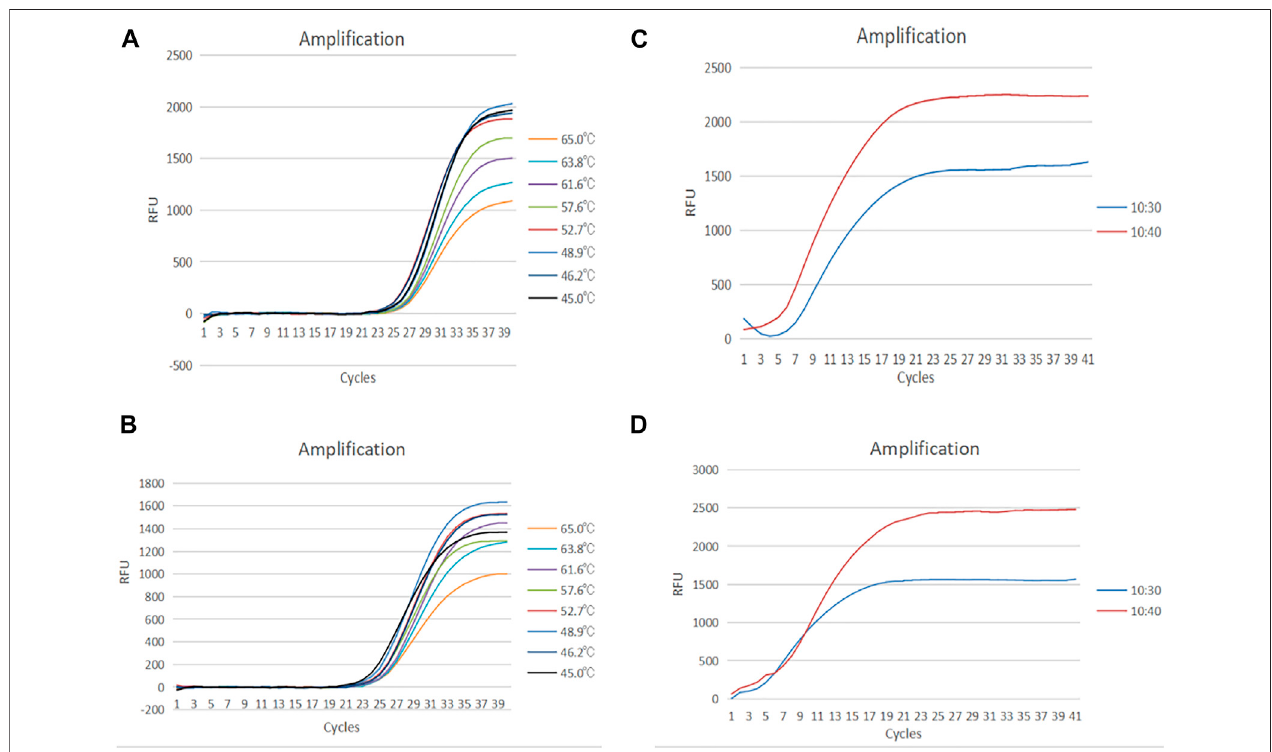
FIGURE2|(A) Ampli fi cationcurveofHADV3from45 ° C – 65 ° C, (B) Ampli fi cationcurveofHADV7from45 ° C – 65 ° C. (C) Ampli fi cationcurveofHADV3witharatioof1 : 4 and 1:3 of RAA volume to PCR volume. (D) Ampli fi cation curve of HADV7 with a ratio of 1 : 4 and 1:3 of RAA volume to PCR